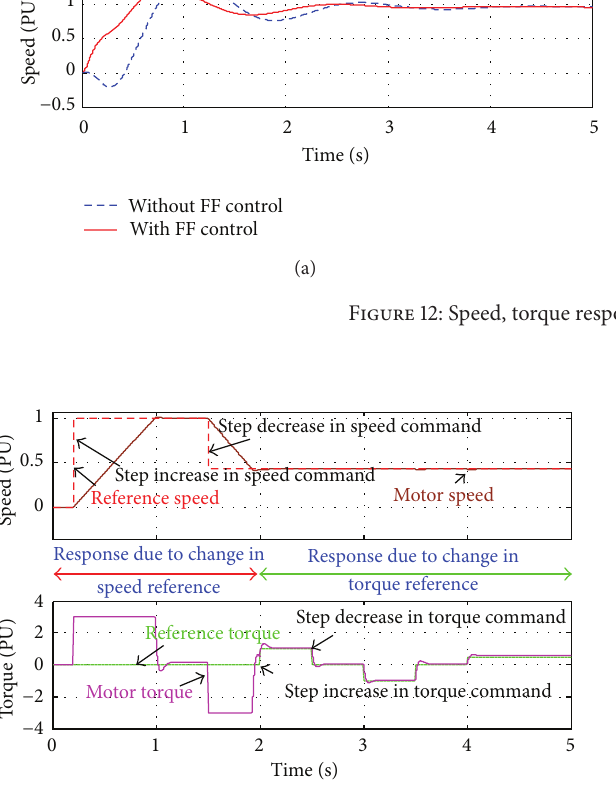
Figure 13: Speed, torque response of IFOC method.